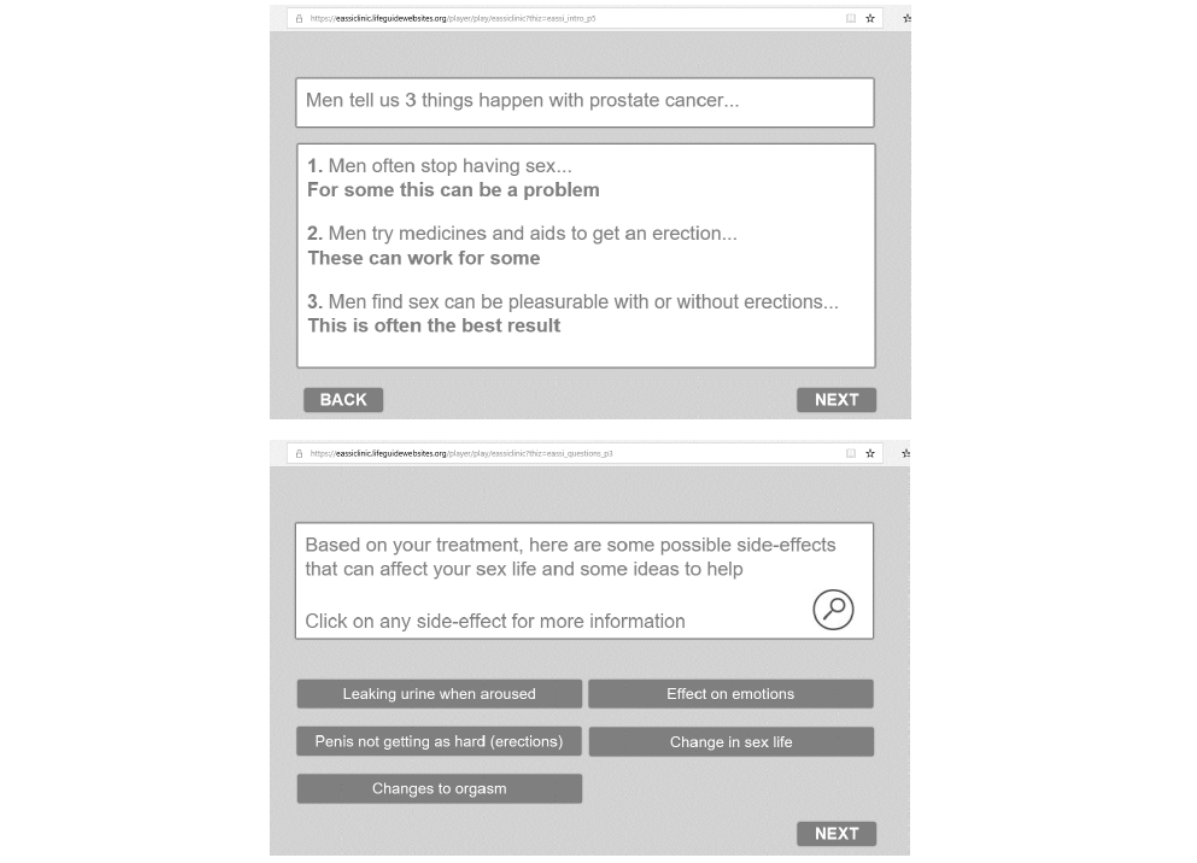
Figure 2. Screenshots showing pages from the "Engagement" and "Support" sections of the tablet-based Engagement, Assessment, Support, and Sign-Posting (EASSi)